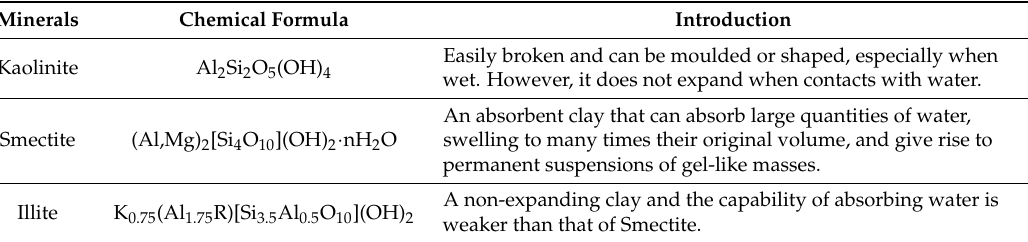
Figure 7. X-ray diffraction result of the Yiluo coal. Table 4. Physicochemical properties of clay minerals.